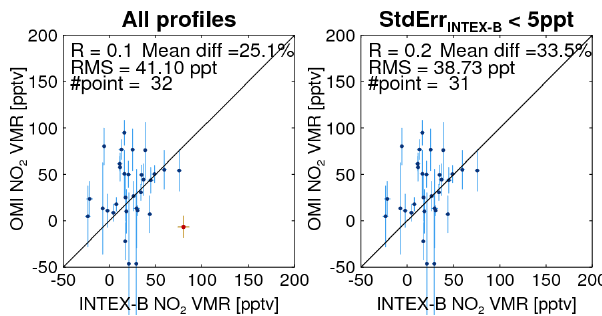
Figure D3. Similar to Fig. 6 but using OMCLDO2 data and geo- metric